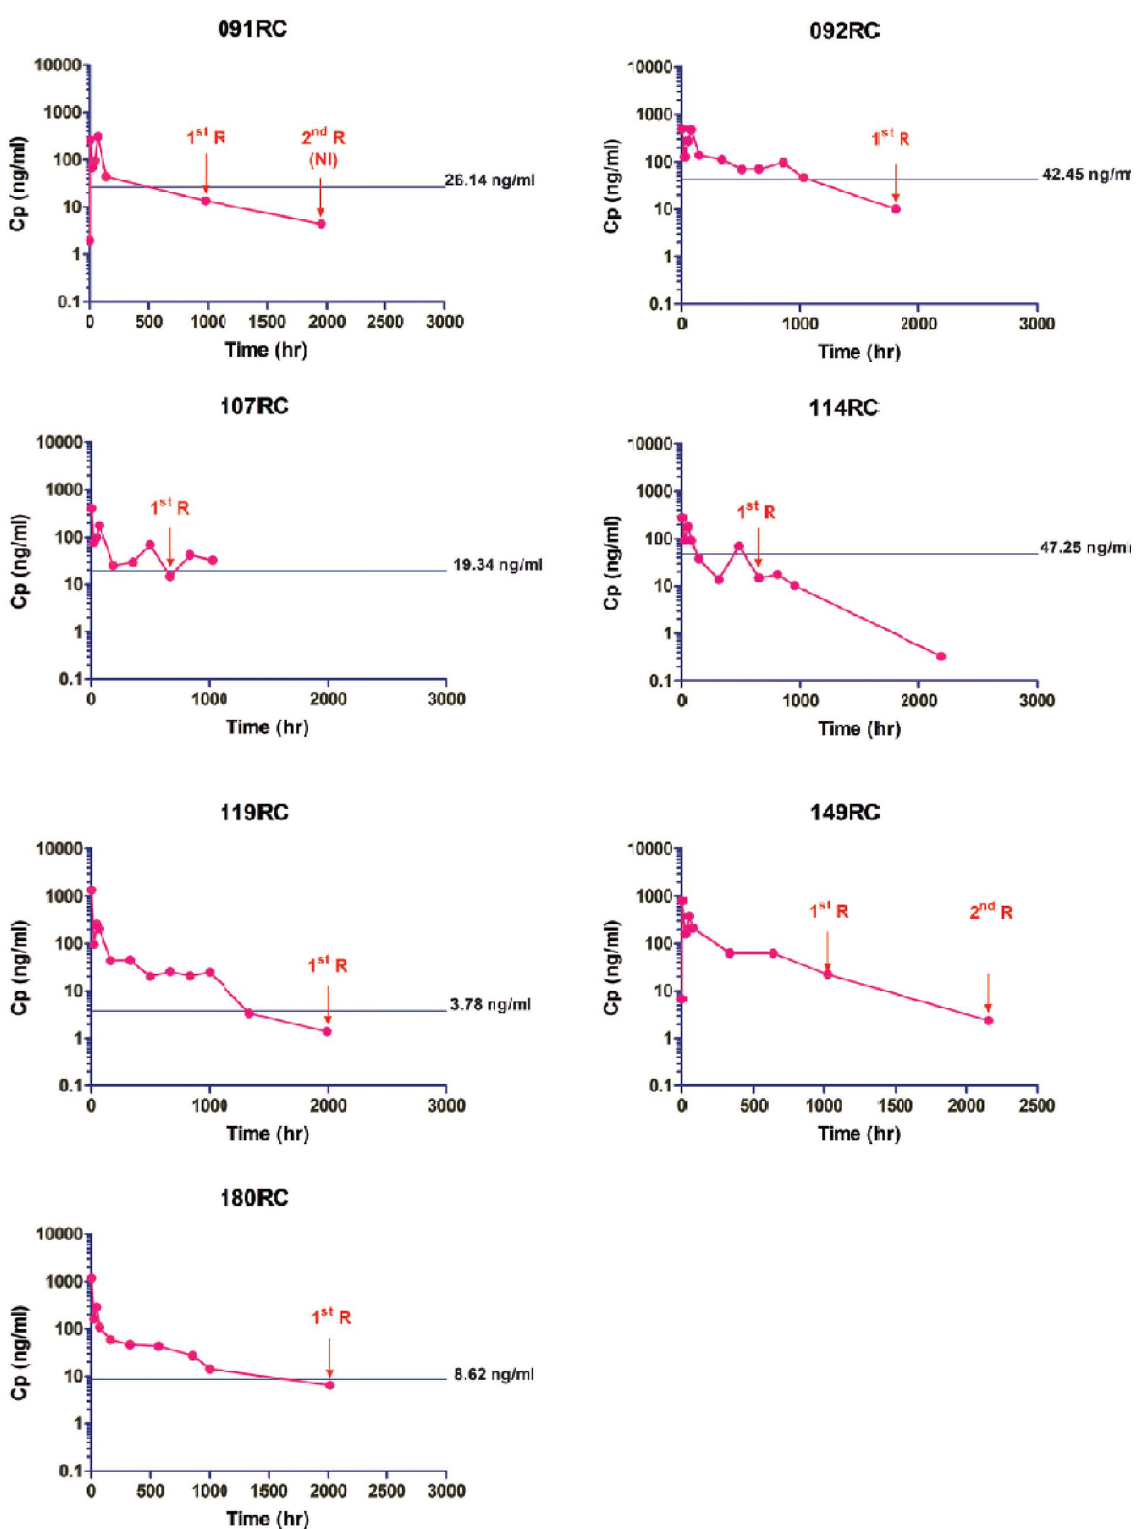
Figure 4. Piperaquine plasma concentration-time profiles in relation to IC 50 for cases of P.falciparum recrudescence. The pink line represents the plasma piperaquine concentration, and the green line represents Day 0 IC 50 , with time of recurrence noted by arrows. Plasma piperaquine is shown as piperaquine phosphate salt concentration (MW 999 ? 56) to match IC 50 calculation method. NI=new infection in case 091. The IC 50 for 149RC could not be assessed due to non-recovery of parasites from the clinical sample.